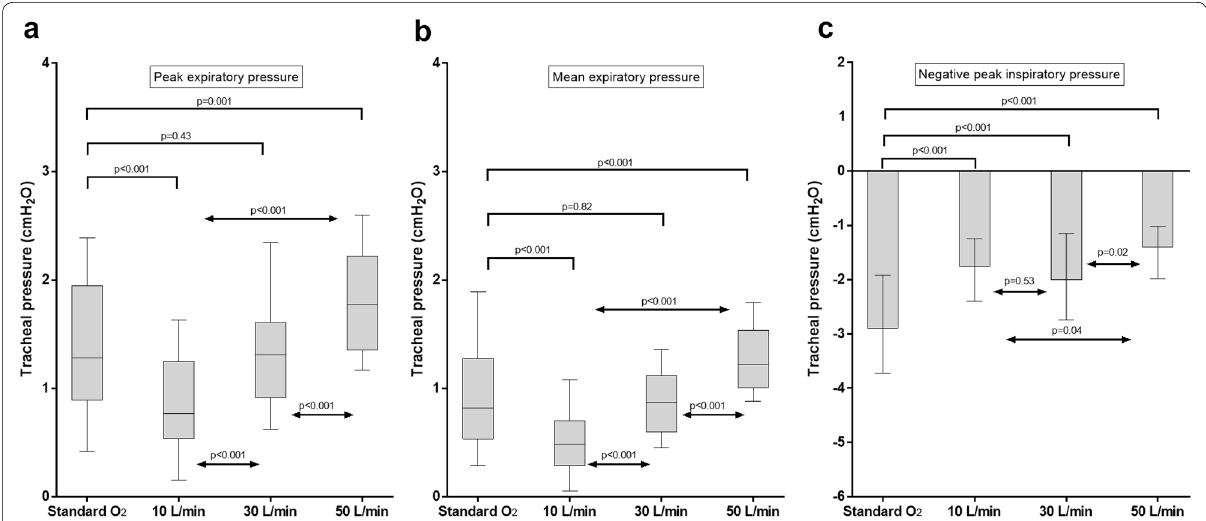
Fig. 2 Peak ( a ), mean expiratory pressure ( b ) and negative peak of inspiratory pressure. Results are displayed as median, interquartile range, maximum and minimum. During HFOT TRACHEAL , tracheal expiratory pressure increases proportionally to the gas flow. All HFOT TRACHEAL settings limit the negative inspiratory pressure, especially as flow is set at 50 L/min, likely due to the capability of the high gas flow in an open system to match patient’s peak inspiratory flow. As compared to standard oxygen, 50 L/min, but not 30 L/min nor 10 L/min, increase tracheal peak and mean tracheal expiratory